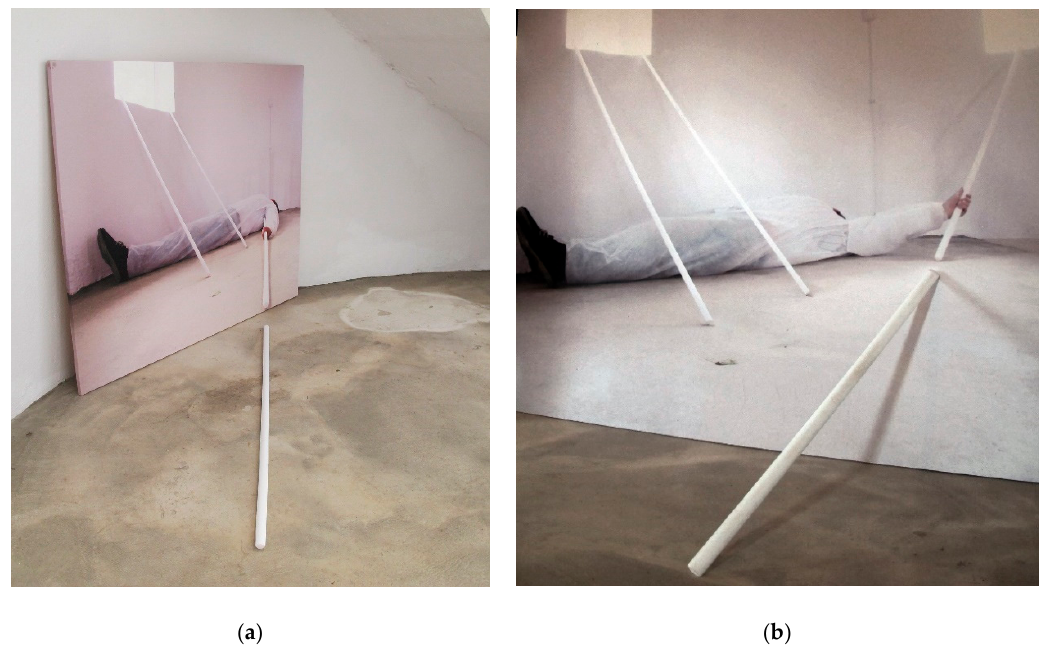
Figure 5. Peter Tzanev, Ectoplastic exercises: ( a ) Out-of-Body Experience, 2018; ( b ) Out-of-Body Experience, 2018; photos: P. Tzanev, 2018.